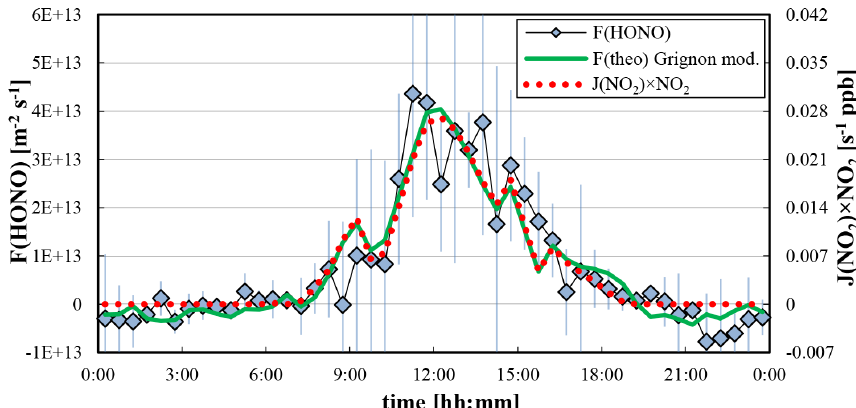
Figure 6. Average diurnal day of the HONO fluxes of the last four days of the campaign in comparison to a modified parameterization from former gradient measurements in Grignon, France (Laufs et al., 2017); see Sect. 5.4. Error bars represent the standard deviation of the HONO fluxes of the 4d. In addition, the scaled product J( NO 2 ) ·[ NO 2 ] is also